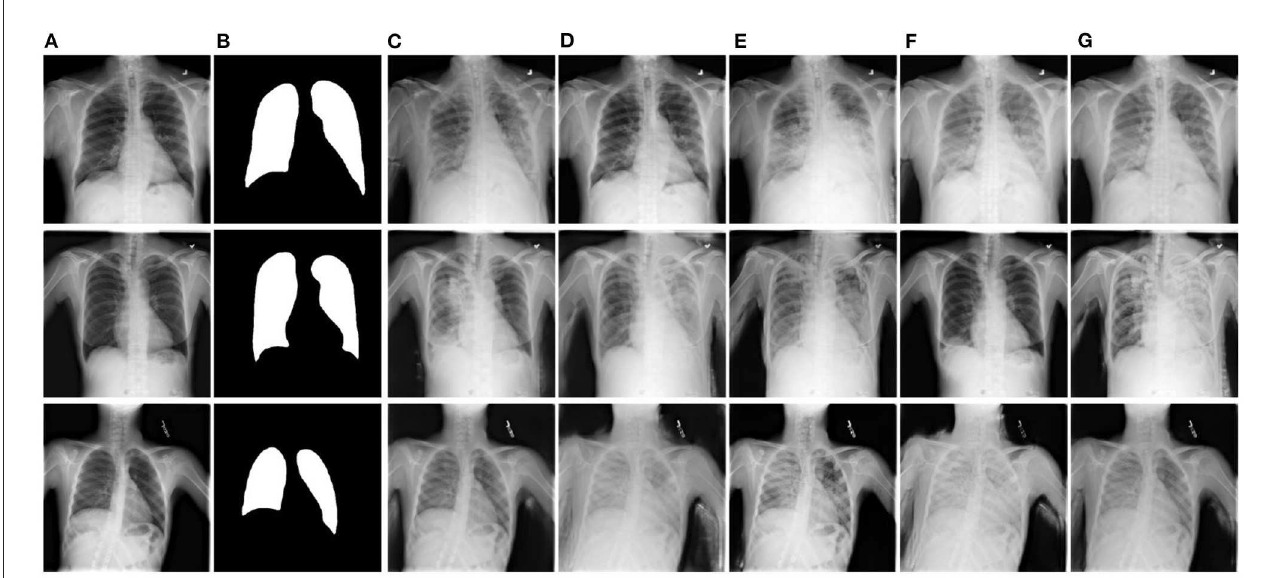
FIGURE6 Showcasing the synthetically generated chest-X ray images. For a given normal image (A) , the proposed approach by Tang et al. (2019b) generates the abnormal images (B–G) is predicted segmentation mask for same input image and results in mask-image pairs from (B–G) . Figure is adapted from Tang et al.